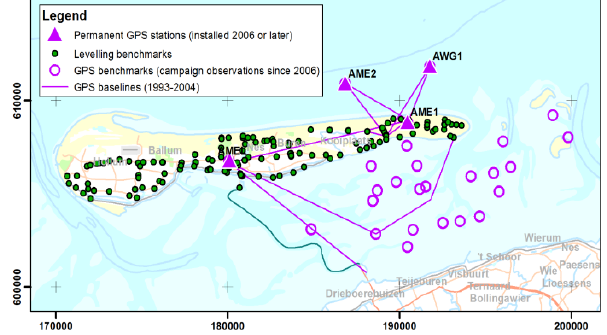
Figure 4. The area around Ameland is measured using a variety of techniques, with different spatial and temporal coverage density (© NAM; source: NAM,